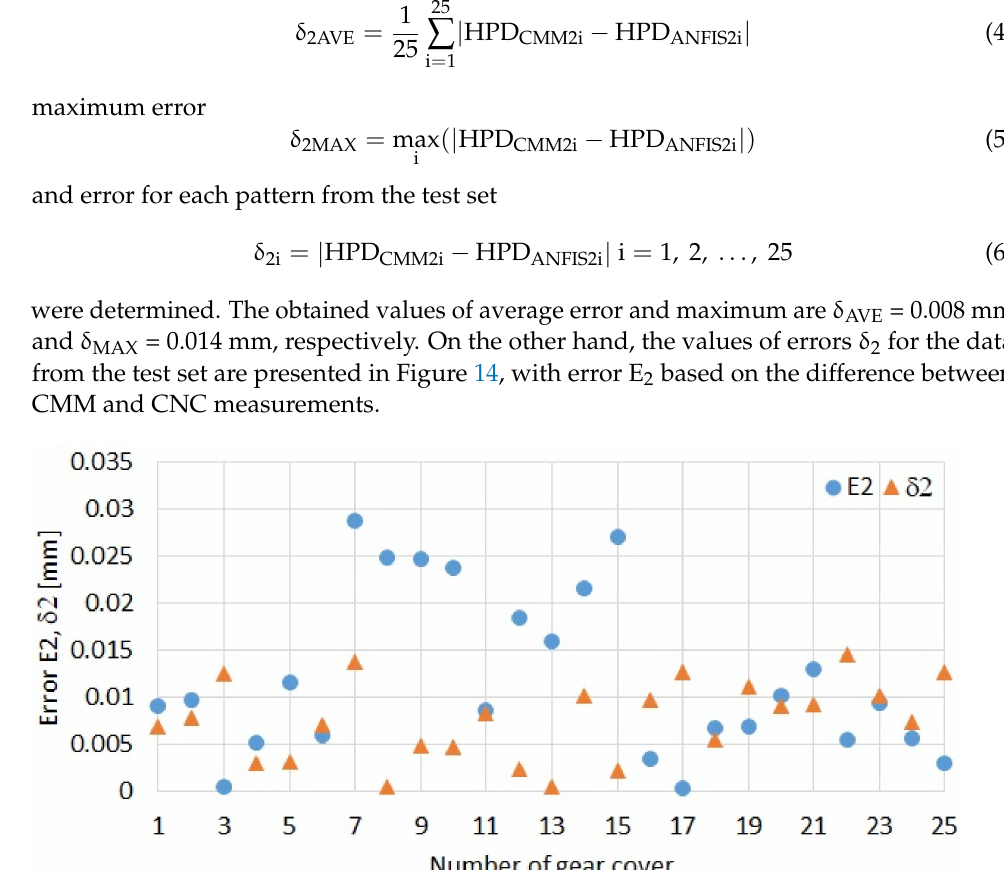
errors E 2AVE = 0.013 mm and E 2MAX = 0.032 mm. Error δ 2AVE constitutes 62% of error E 2 AVE